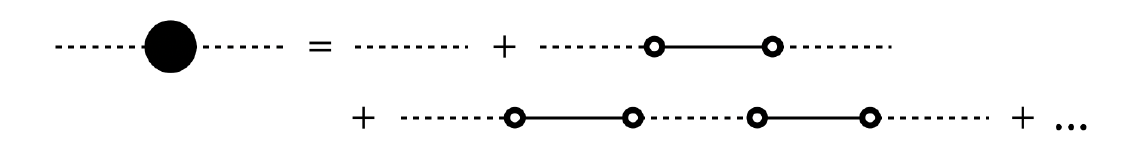
Figure 4. “Dressed” dislon propagator. This is the counterpart of the “dressed” phonon propagator in terms of the dislon field. This object has the advantage that it explicitly conserves energy and momentum along all dimensions in which the string is extended, whereas the exact phonon propagator only conserves energy and momentum along the dimensions that are shared with the string (time and the ˆ e 3 axis).